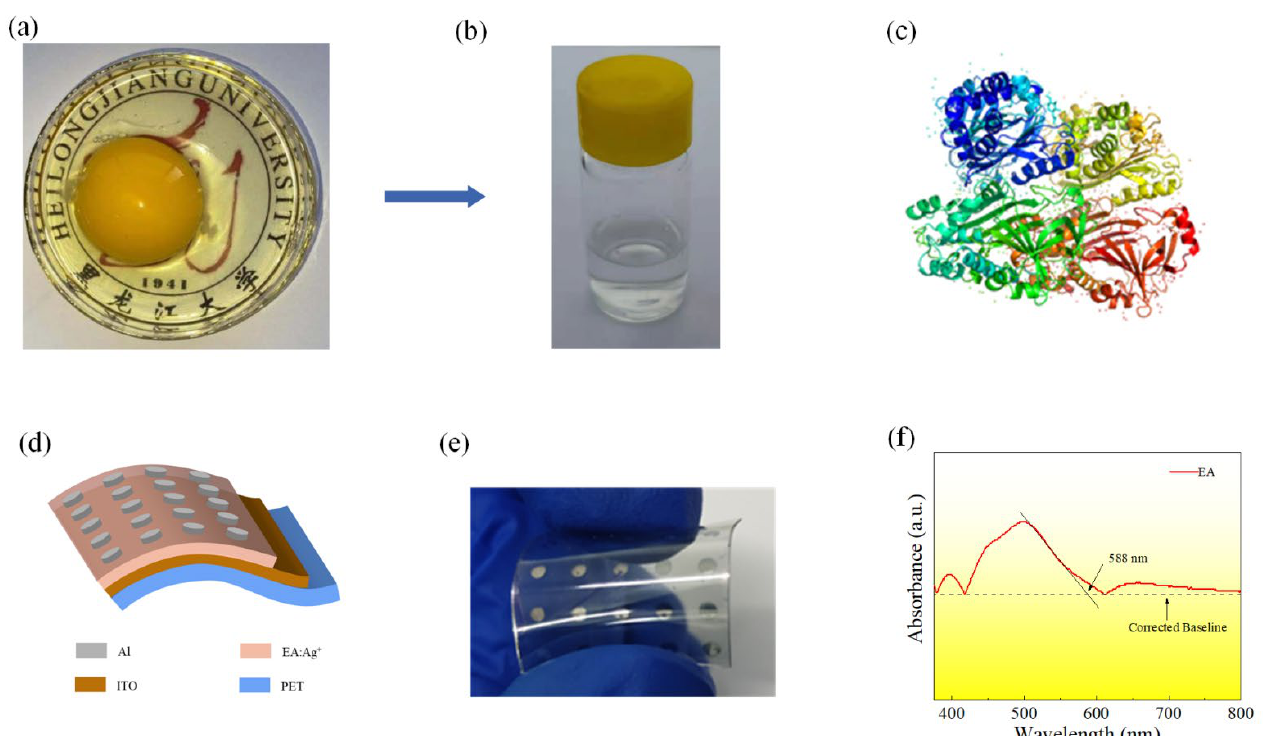
Figure 1. ( a ) The egg white and yolk of a whole egg. ( b ) Silver-ion-doped egg albumen solution. ( c ) Three-dimensional schematic diagram of ovalbumin. ( d ) Schematic diagram of Al/EA:Ag + /ITO memory devices. ( e ) Physical image of Al/EA:Ag + /ITO memory devices. ( f ) UV-Vis spectra of the EA film.